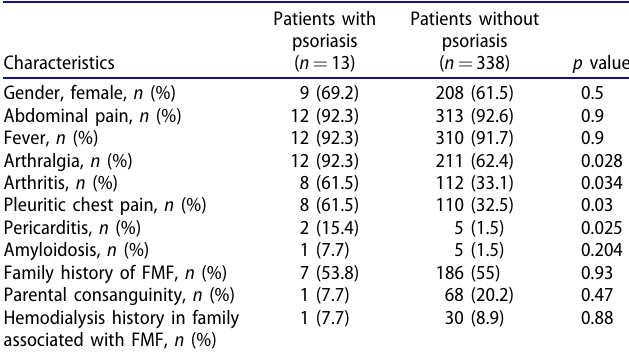
Table 2. Comparing demographic and clinical characteristics of familial Mediterranean fever (FMF) patients with or without psoriasis. Characteristics